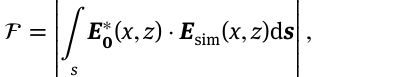
ulations are iterated until the figure of merit